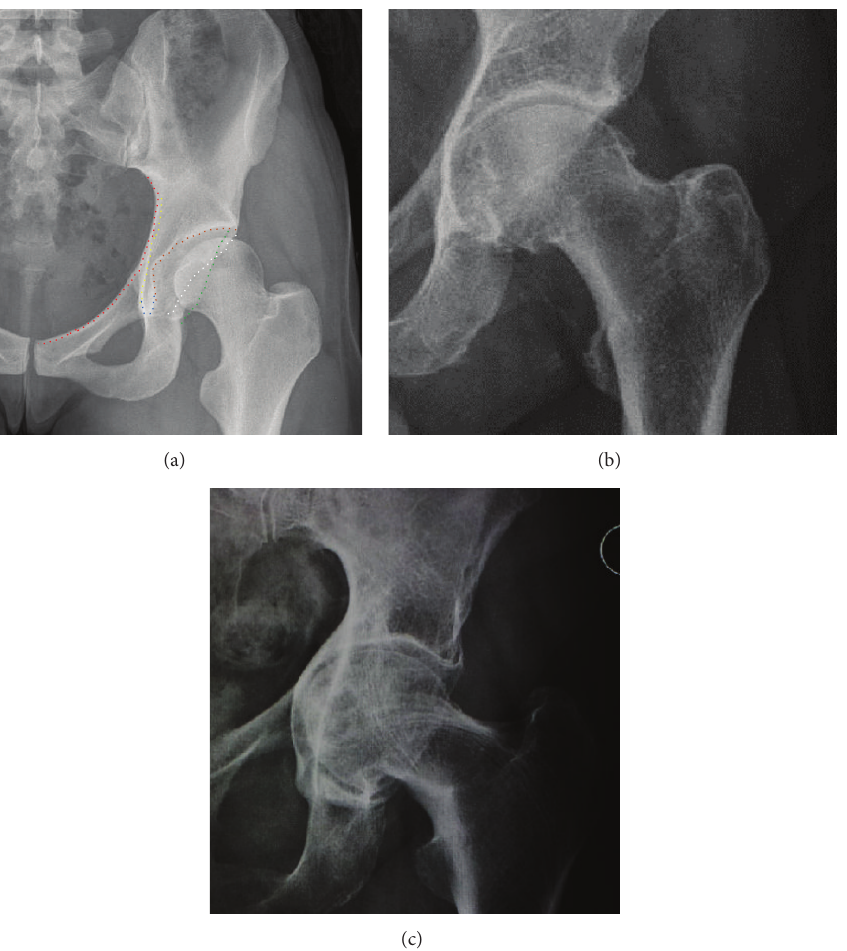
Figure 5: (a) Iliopectineal line (red), ilioischial line (yellow), tear drop (blue), acetabular fossa (brown), and anterior (white) and posterior (green) wall of the acetabuli showing mild upper crossover sign. (b) Coxa profunda. (c) Protrusio